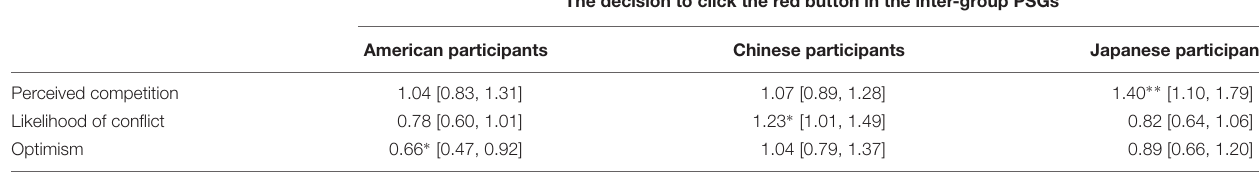
TABLE 3 | Regressing preemptive strikes onto preexisting perceptions about bilateral